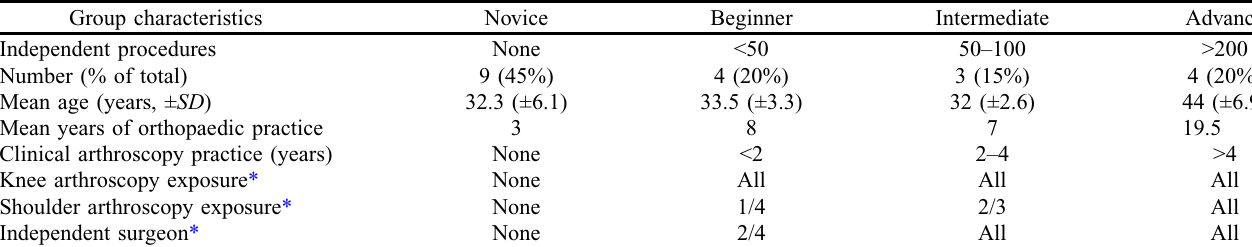
Table 1. Participants profile and arthroscopic experience of subgroups.